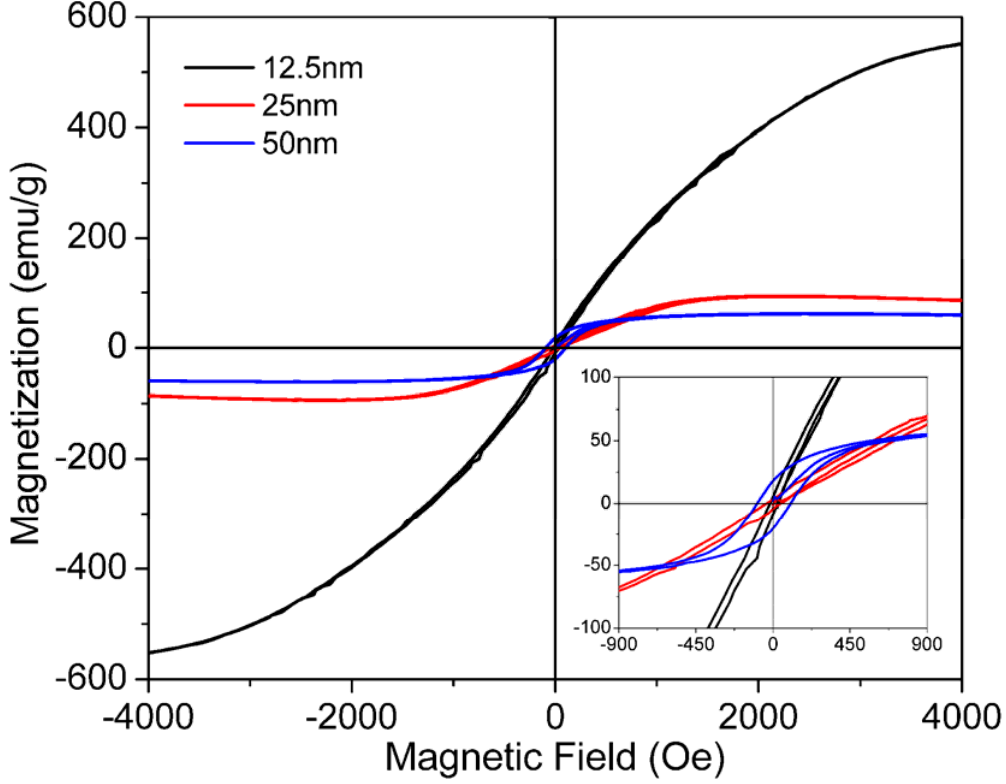
Figure 10. Typical M-H hysteresis curves of LSMO nanofilms with different thicknesses on 3D ZnO nanorod arrays measured at 80 K with magnetic field applied parallel to the film. Inset: the detailed M-H hysteresis curves at low magnetic